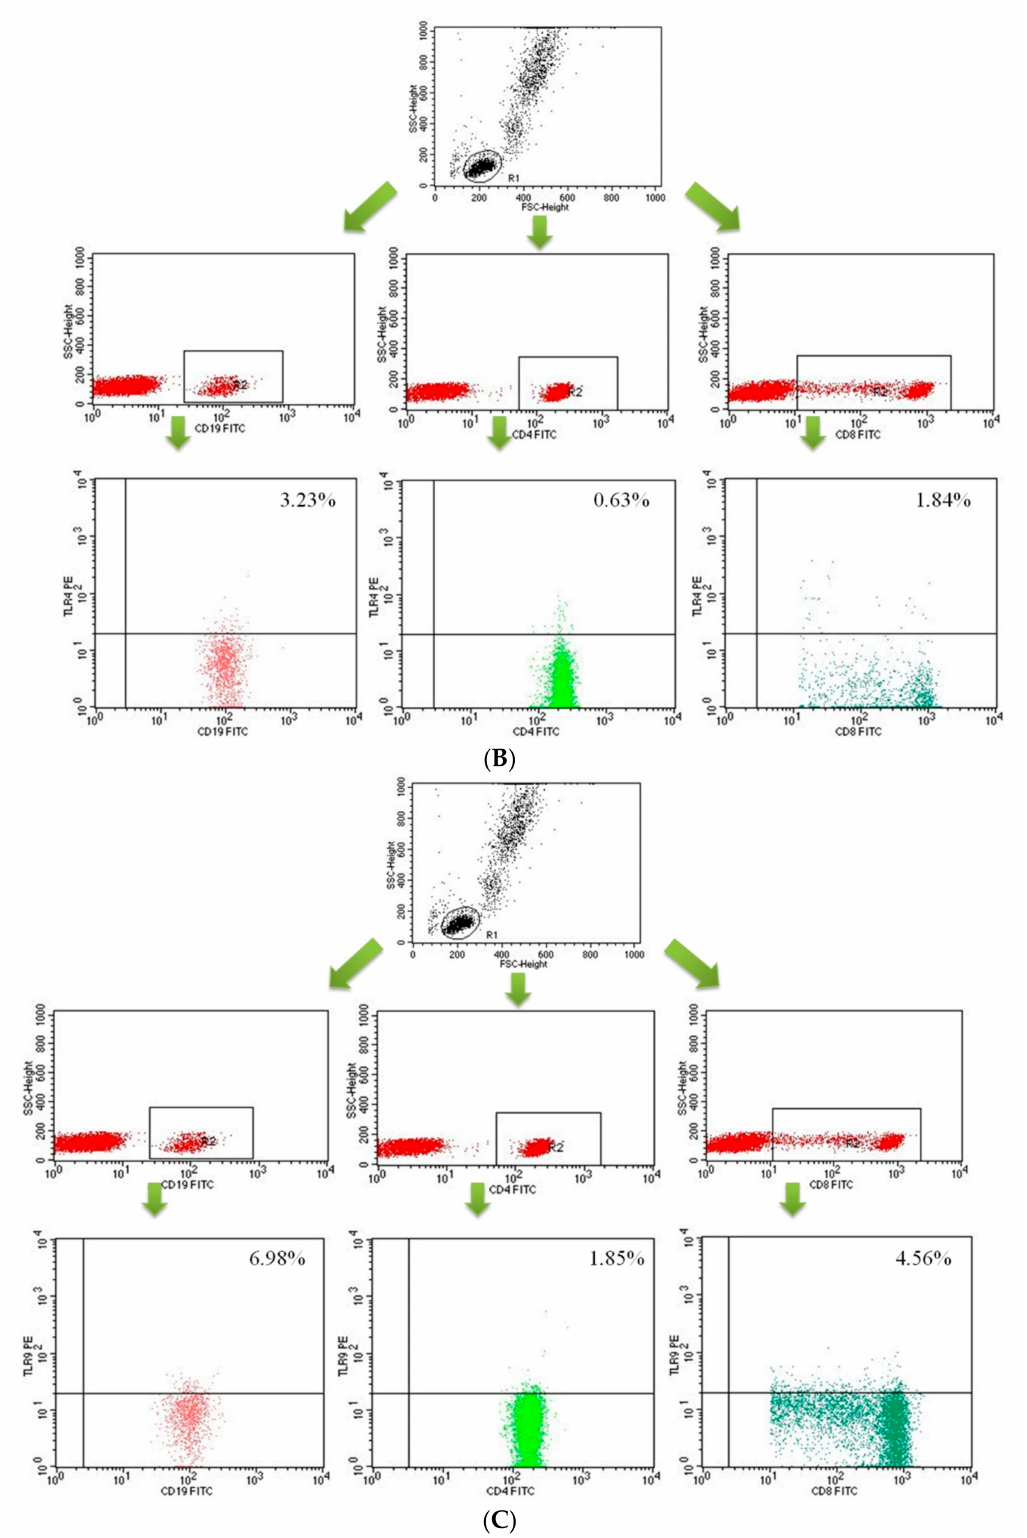
Figure 10. Dot-plots showing the percentage of B lymphocytes (CD19+) and T lymphocytes (CD4+, CD8+) with TLR2 expression ( A ), B lymphocytes (CD19+) and T lymphocytes (CD4+, CD8+) with TLR4 expression ( B ) B lymphocytes (CD19+) and T lymphocytes (CD4+, CD8+) with TLR9 expression ( C